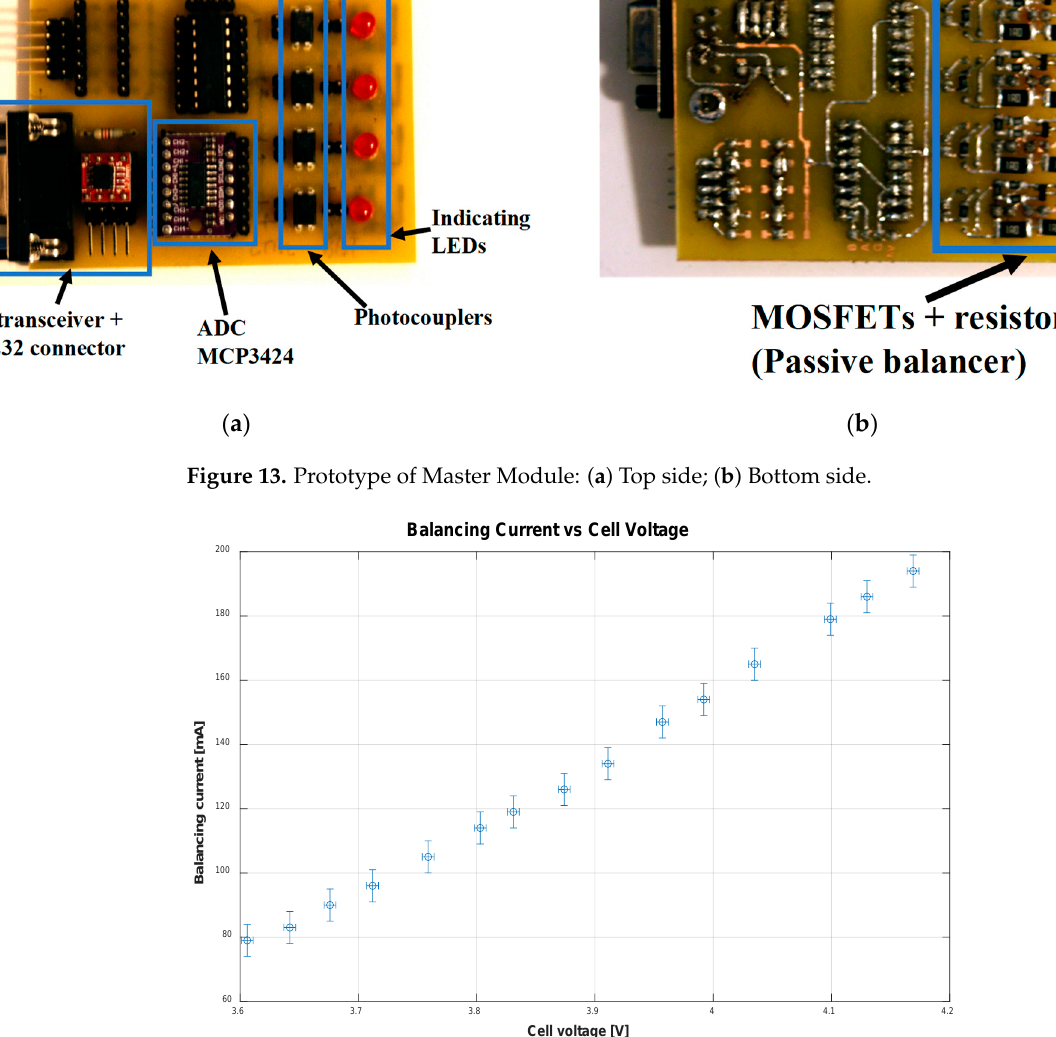
Figure 15. Experiment setup for measurement of current and voltage.